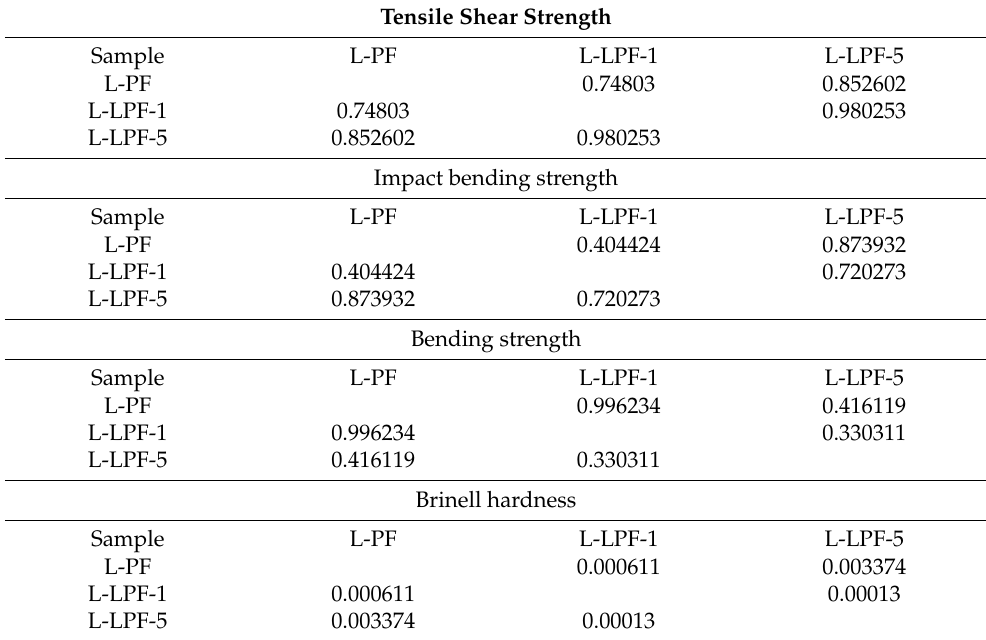
Table 4. The p -values of differences presented in Figure